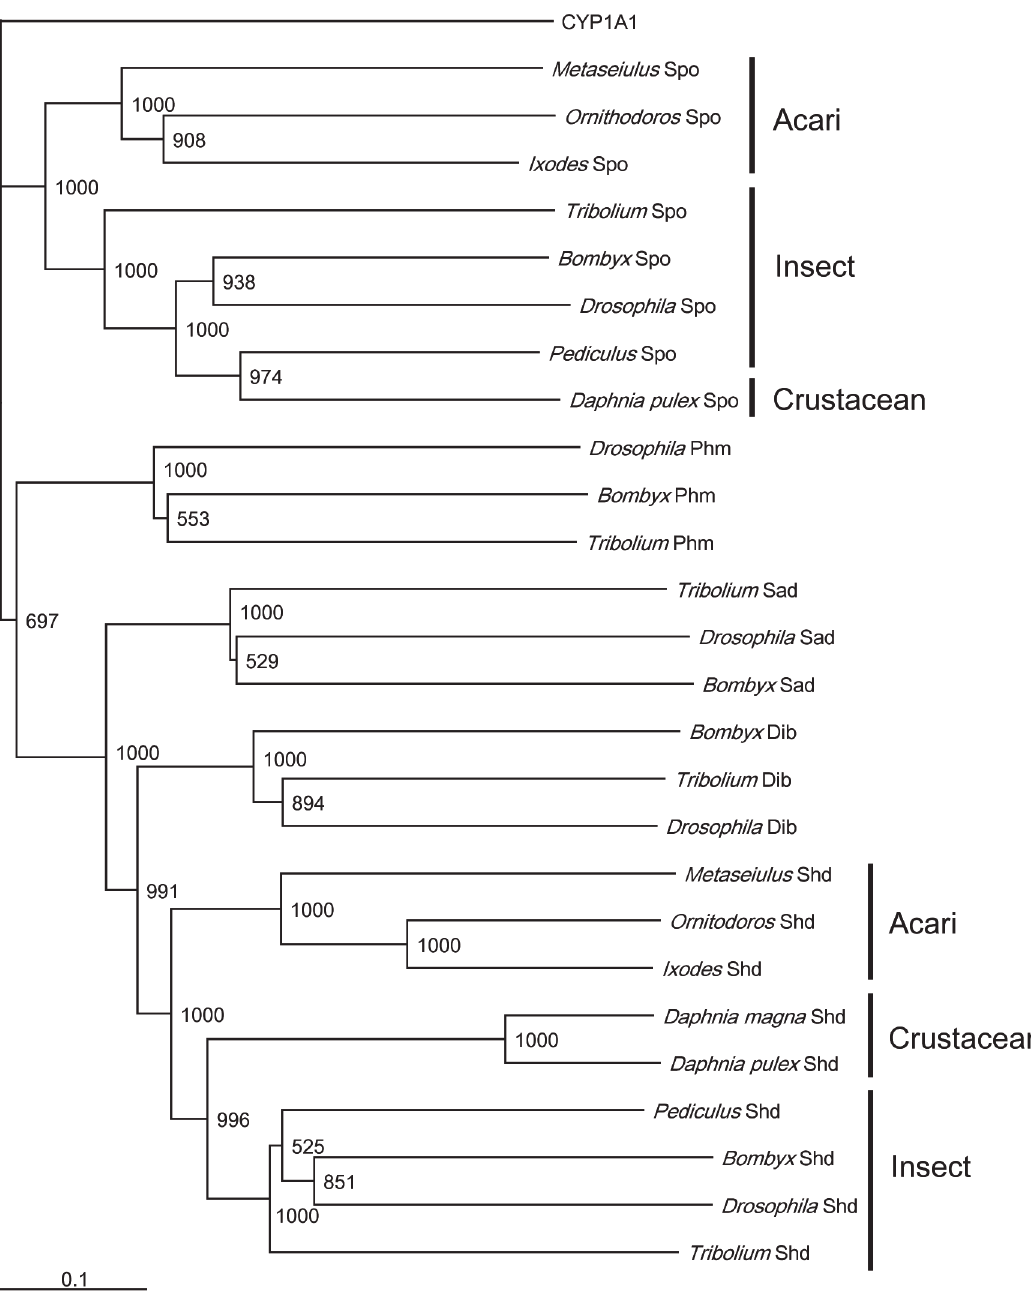
Fig 3. Phylogenic tree of CYPs associated with ecdysteroidogenesis. A phylogenetic tree of CYPs was constructed by the Neighbor-joining method. The bootstrap values (1000 replications) are represented at the branches. The scale bar indicates the numbers of amino acid substitutions per site. Gene numbers used for this analysis are described in the materials and